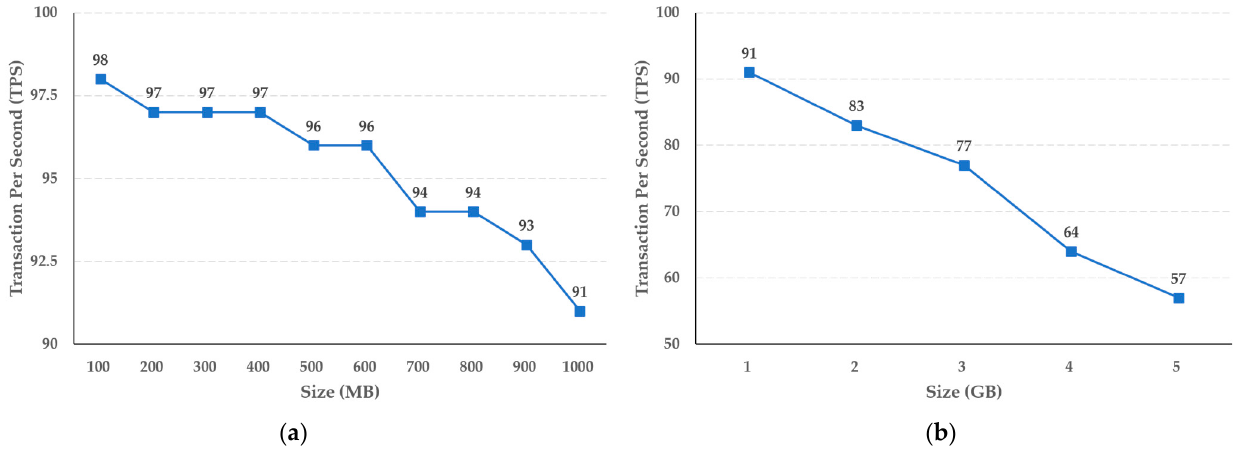
Figure 8. Results of crime evidence video retrieval performance ( a ) per MB, and ( b ) per GB in the cold blockchain system.